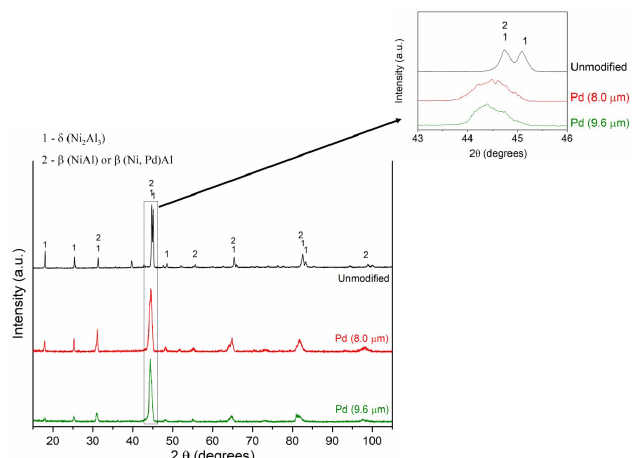
Figure 2. XRD of the surface of (unmodified and Pd-modified) aluminized coatings after processing at 1030 °C. Insert is a zoom-in view of the main peak region.